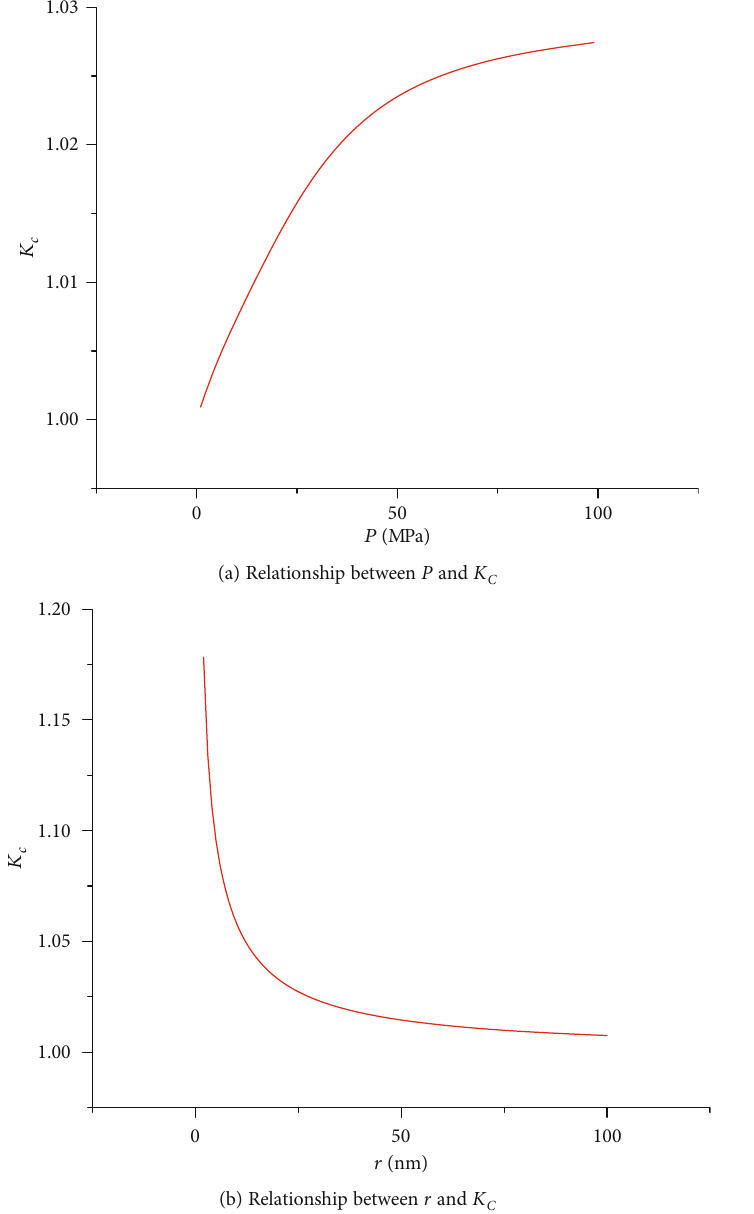
= 0 : 7 nm , h = 0 : 3nm , w m